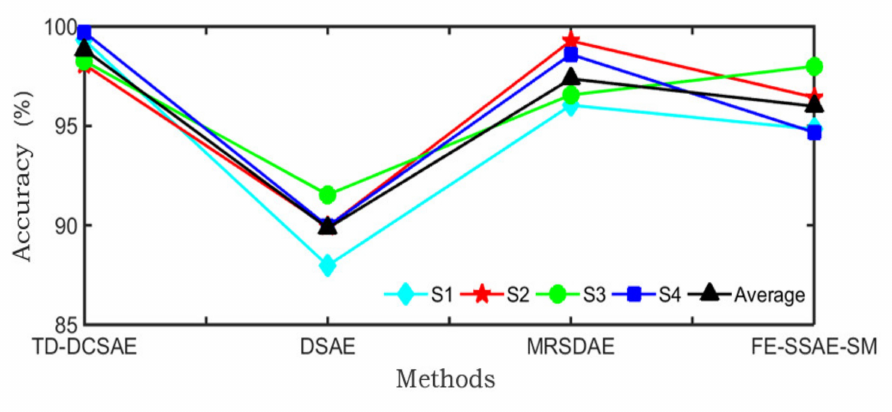
Figure 9. The accuracy of different methods under different working conditions. Table 4. The accuracy under a different number of labeled samples in the target